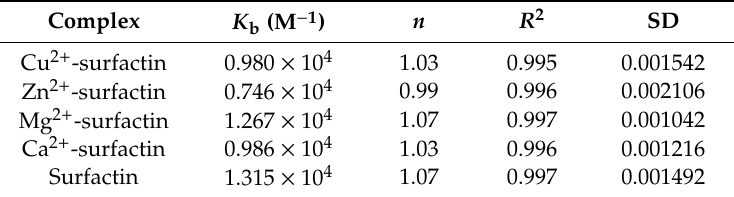
Figure 6. Plots of log[( F 0 − F) / F] versus log [Q] for surfactin- and metal-surfactin complexes-BSA binding; pH = 7.4; T =25 °C. Table 3. Binding constants ( K b ) and number of binding sites ( n ) of BSA with surfactin and metal-surfactin complexes at 25 °C.